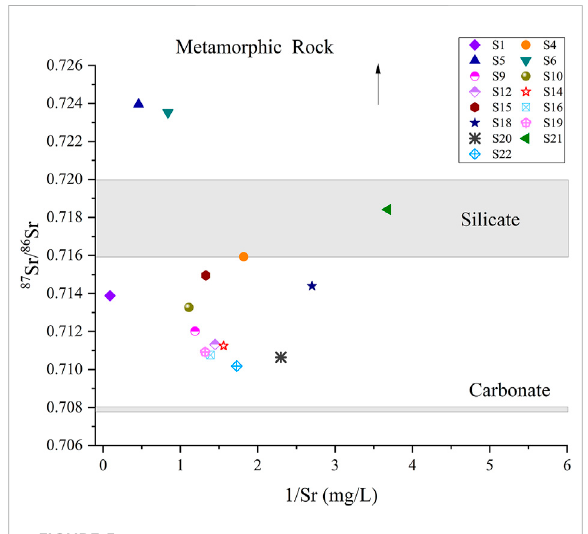
FIGURE 5 CharacteristicsoftheSrisotopeofthethermalspringwaterin the Qilian Mountain